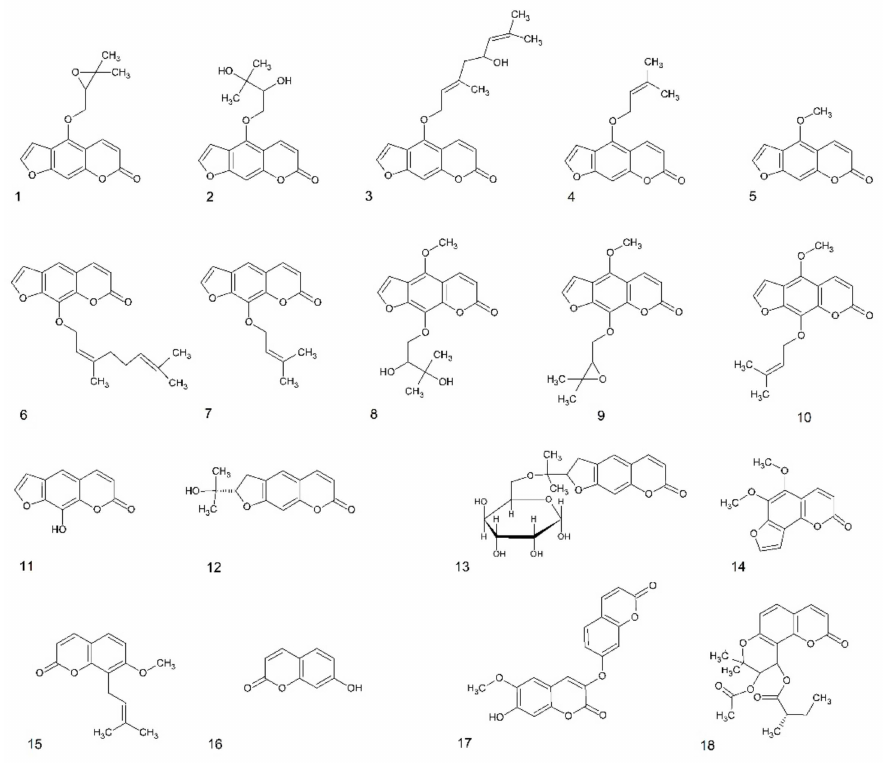
Figure 1. Structures of coumarins used in this study. Furanocoumarins: